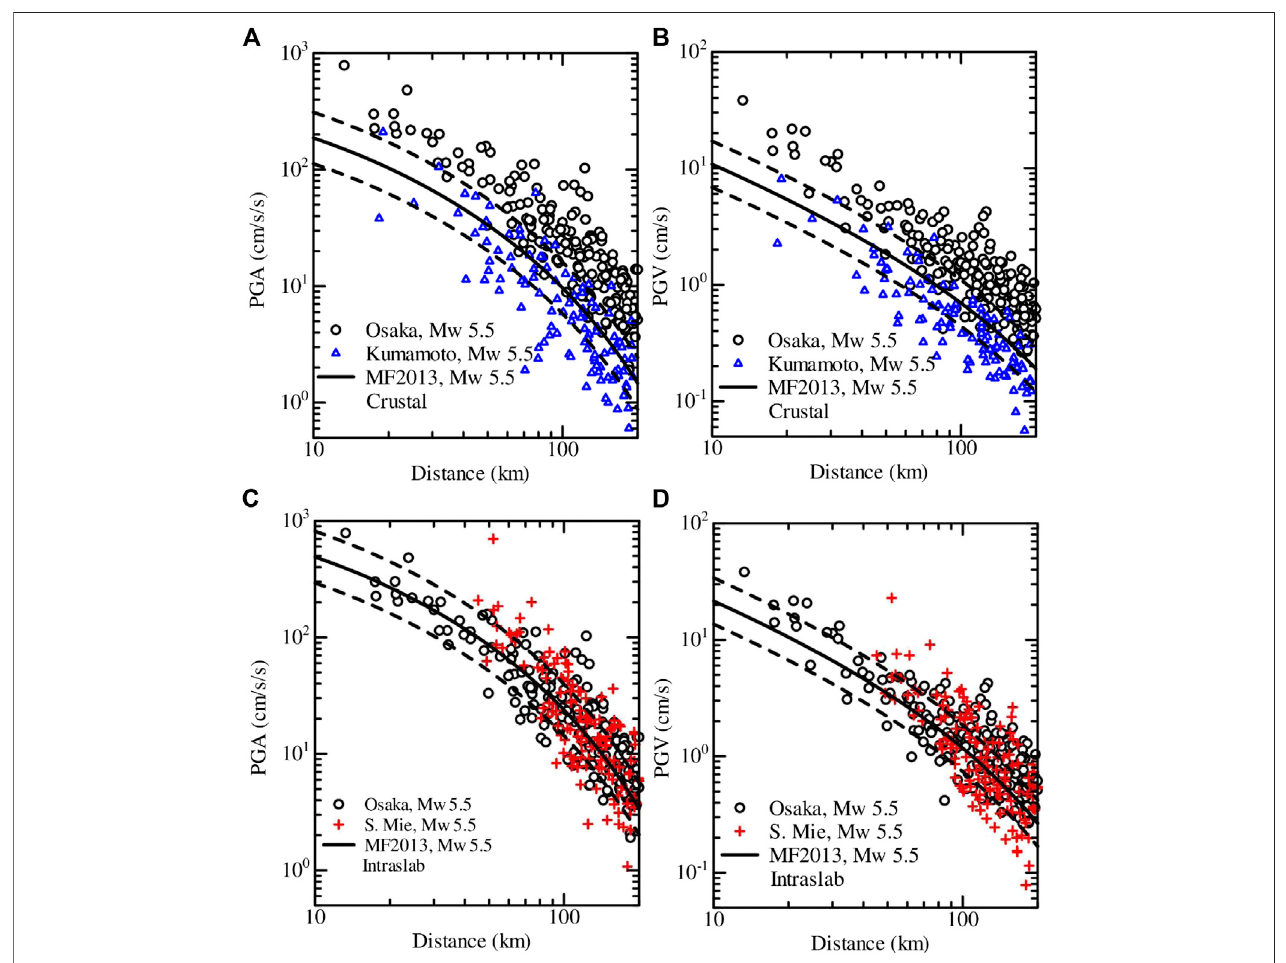
FIGURE 13 | Comparison of the PGAs and PGVs between three events having identical Mw value of 5.5 (F-net, NIED). A-B : between the North Osaka and northeast Kumamoto Prefecture earthquakes. C-D : between the North Osaka and southern Mie Prefecture earthquakes. The horizontal axes denote the hypocentral distance.Thecircles,crossmarks,andtrianglesdenotetheadjustedvaluesbysitecorrectionsusingequationsinMorikawaandFujiwara(2013)fortheeventsindicated in each panel. See Figure 9(a) for the location of the events. See the text for further explanation.